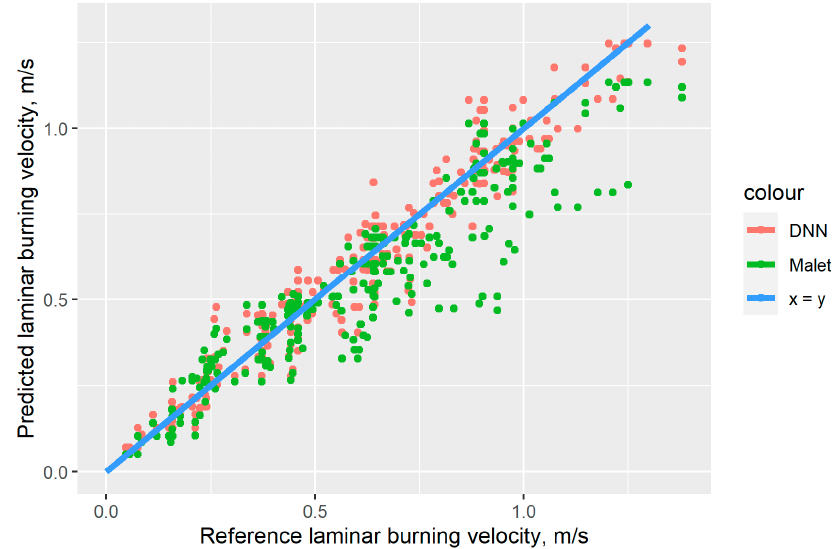
Figure 6. Malet and DNN comparison.